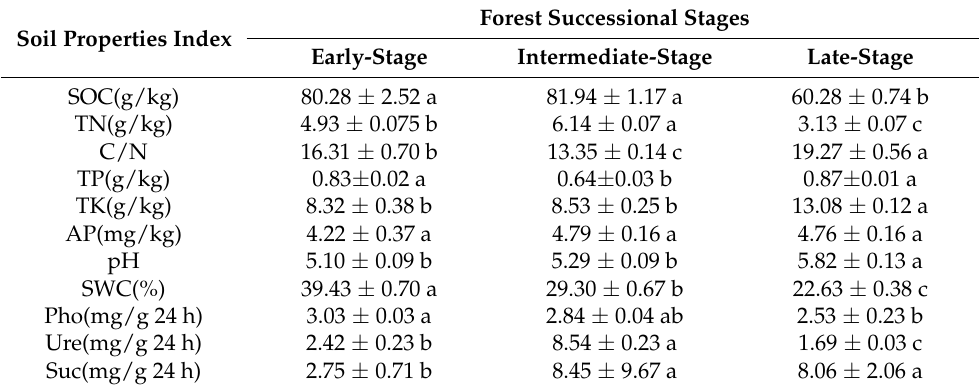
Table 2. Changes in soil properties in the forest with different successional stages of broad-leaved Korean pine forest in the Lesser Hinggan